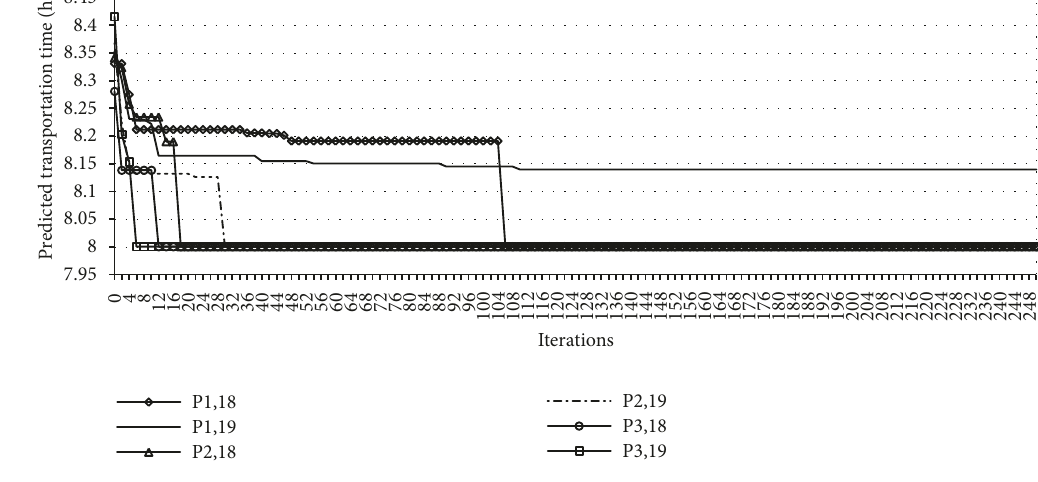
Figure 13: The convergence procedure of each path based on predicted transportation time.